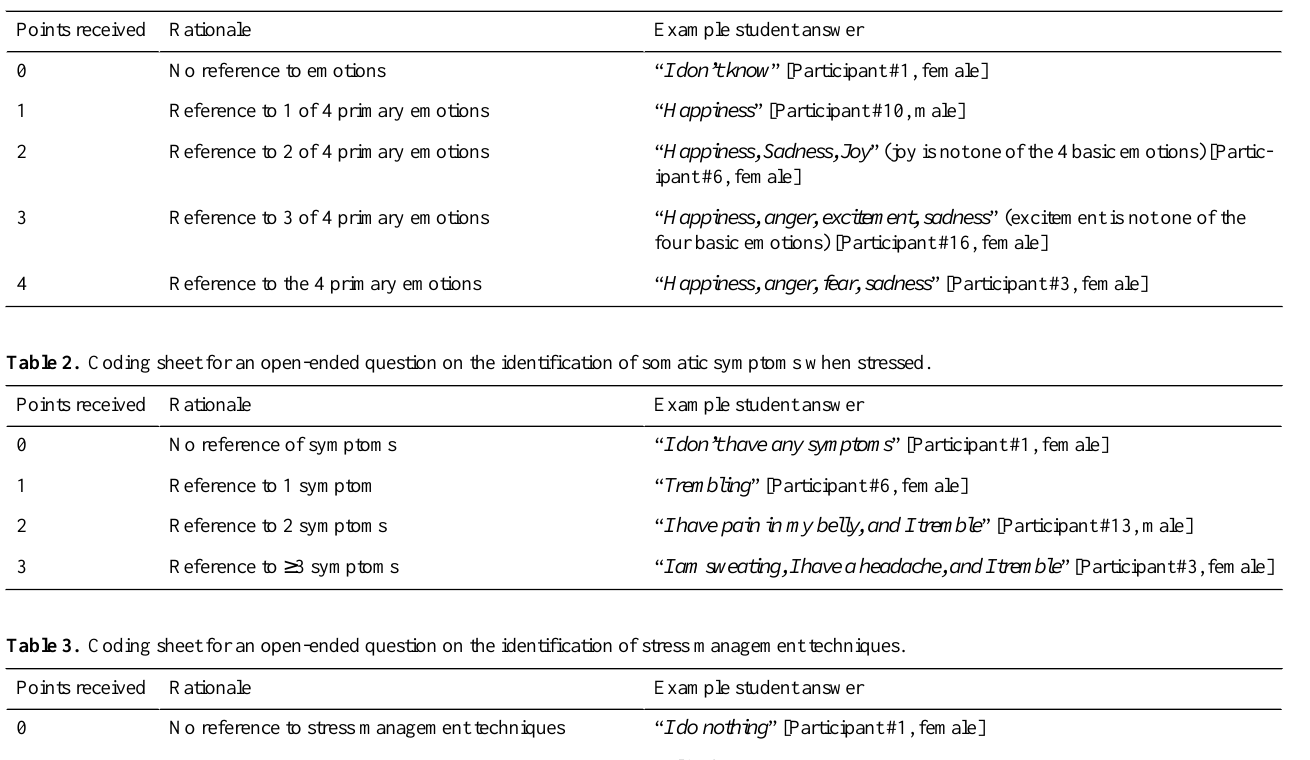
Table 1. Coding sheet for an open-ended question on basic emotion identification.